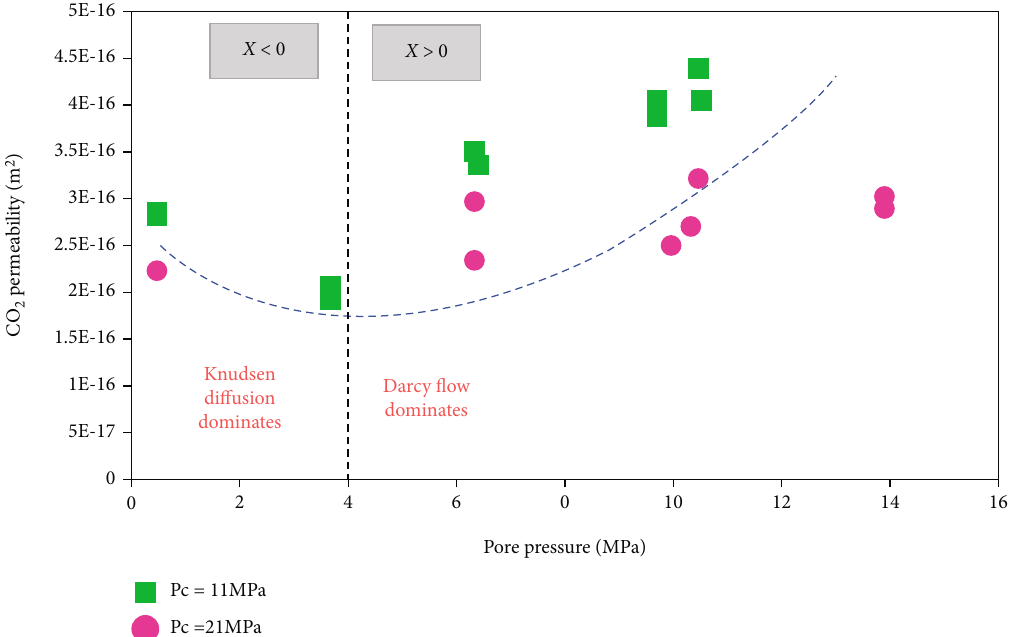
Figure 9: Permeability evolution curve evaluated by bivalued e ff ective stress coe ffi cients for the 3.71mm shale disk